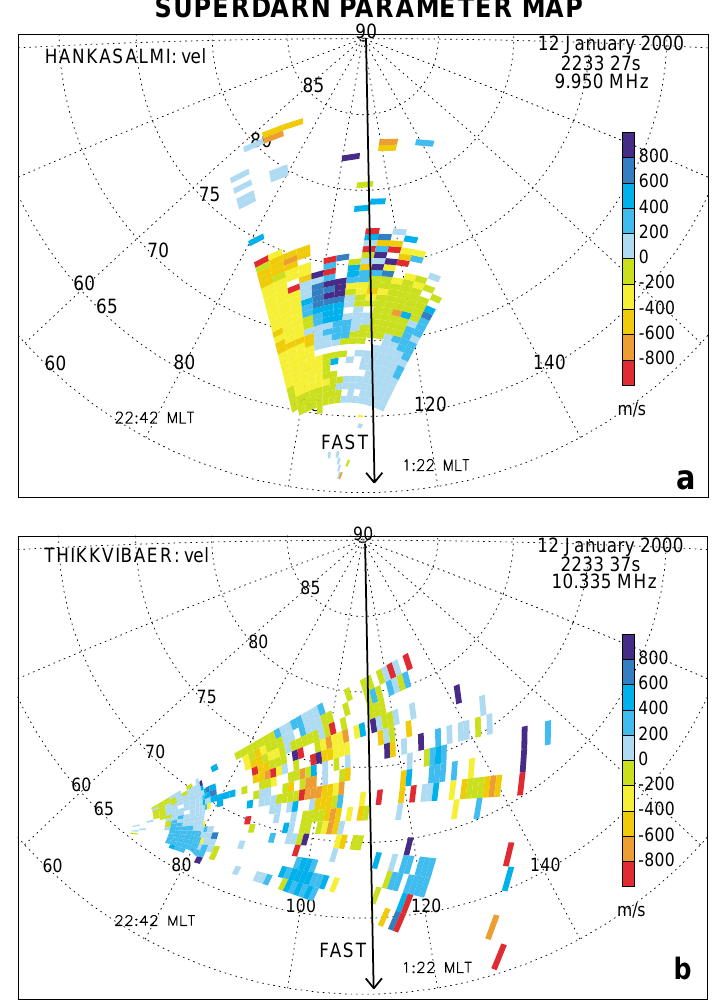
Fig. 11. Line-of-sight velocity maps of the Pikkvibær (top panel) and Hankasalmi (bottom panel) radars in AACGM coordinates, at the time of the FAST pass, with the FAST orbit super-